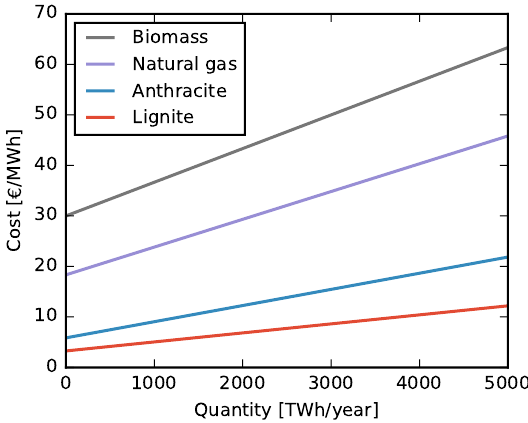
Figure A3. Supply curves, i.e., fuel cost as a function of total quantity consumed annually in the model, for lignite, coal, gas and biomass. Note that for biomass, this only refers to internationally-traded fuel. Each country also has a supply of local biomass